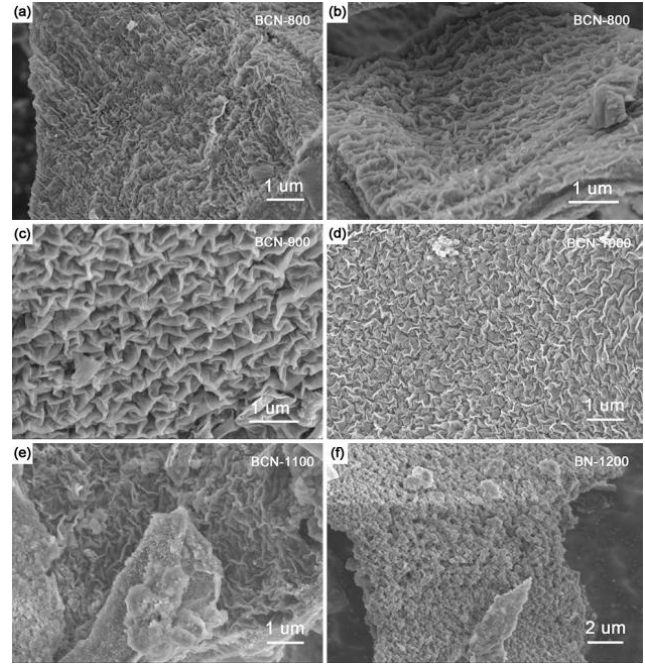
Figure 3. SEM images of ( a , b ) BCN-800; ( c ) BCN-900; ( d ) BCN-1000; ( e ) BCN-1100; ( f ) BN-1200.